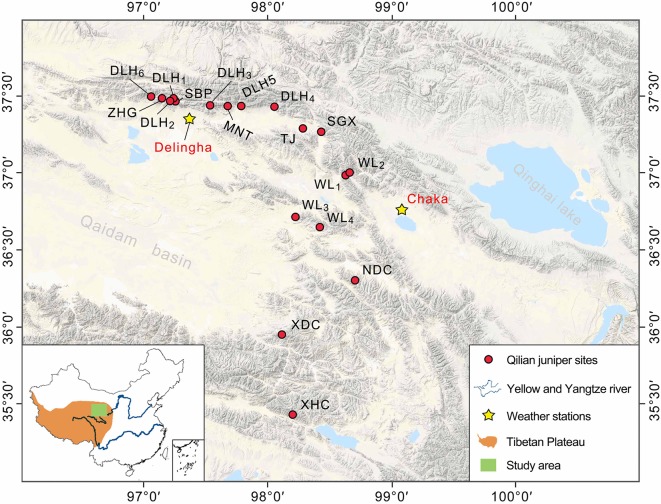
The location of the study area and sampling sites. The Qilian juniper site names and other geographic information refer to Shao et al. (2009) and Yang et al. (2014).